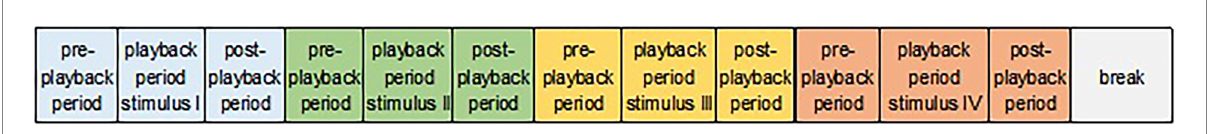
FIGURE 2 Scheme of one experimental trial consisting of two playback stimulus types (feeding buzzes and courtship calls) of the two species ( P. nathusii and N. noctula ) resulting in four different playback